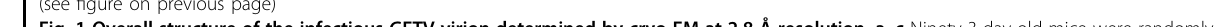
with E2 H170 in CHIKV 34 ). Other residues in this inter- action region include E1 ’ s A92 and Y93 and E2 ’ s H226. These three residues are located at the interface between E1 ’ s fusion loop and the E2 domain B, similar to reports for SFV 35 and CHIKV 34 .